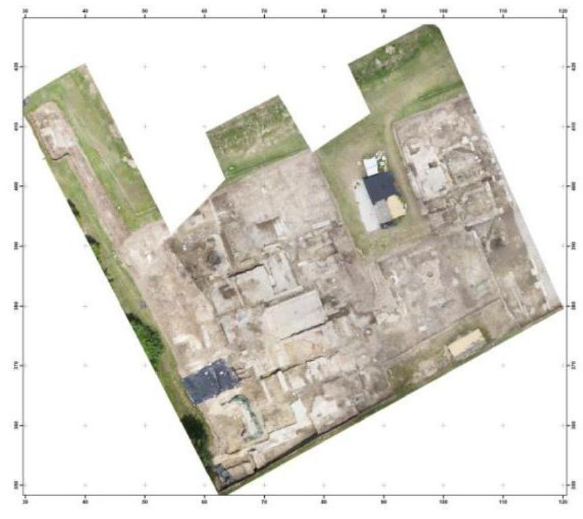
Figure 8. The orthophoto of the Domus “dei putti danzanti” Another product that has been made, with both the two- dimensional aspect typical of an orthophoto, and the height information typical of a DSM, is the solid orthophoto (OSP), [Dequal, 2003]. The OSP is a raster product which associates to each pixel in a geo-referenced matrix the chromatic information (and eventually radiometric multi-spectral information) and the height: in this way, the available data can be placed in their correct three-dimensional location even if the user can observe only in 2D.